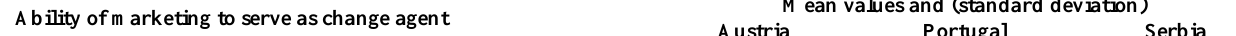
Table 7: Mean values for statements measuring the transformational potential of marketing Ability of marketing to serve as change agent